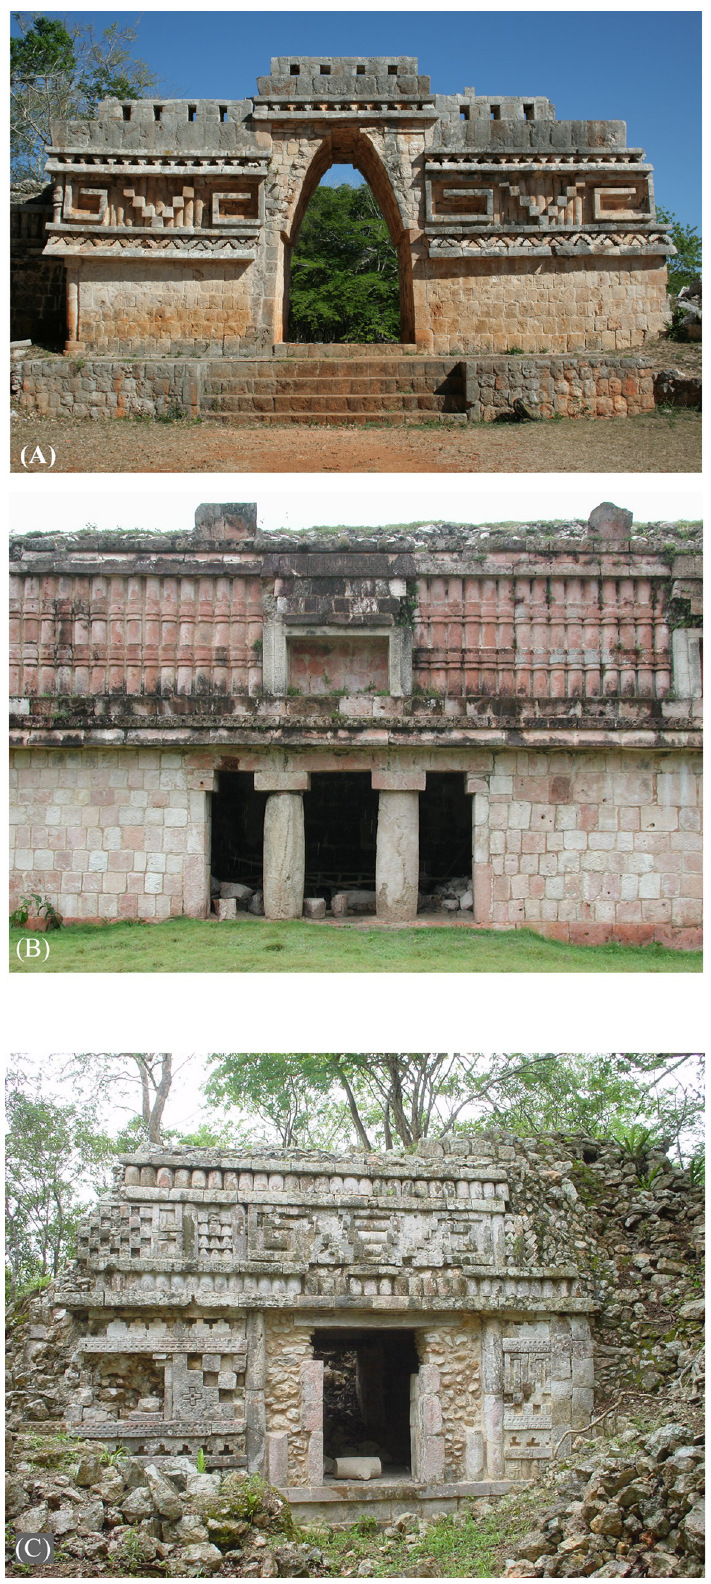
Fig 1. Typical examples of Puuc masonry architecture. (A) Labna. (B) Chacmultun. (C) Rancho Pe´rez.